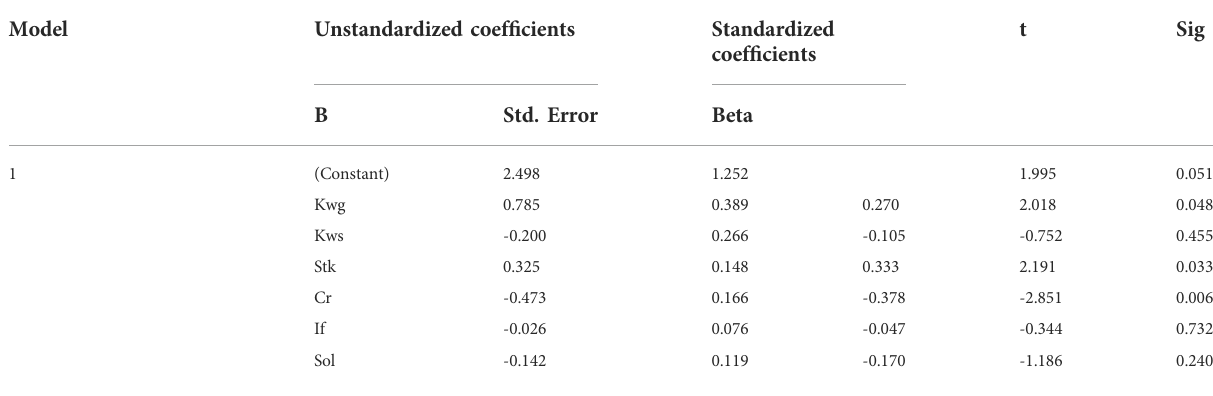
TABLE 18 Coef fi cients corresponding to the independent variables for